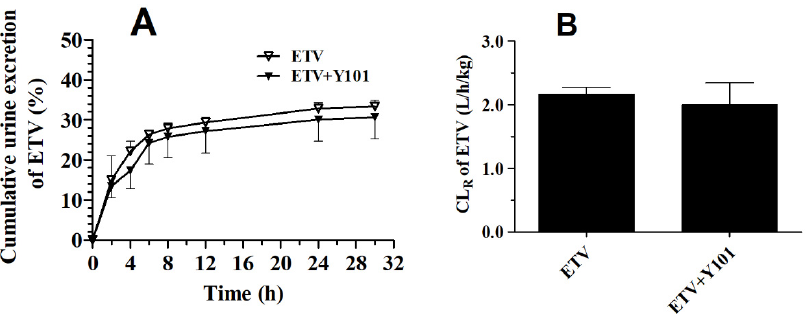
Figure 5. Cumulative urine-excretion curves of ETV ( A ) and the renal clearance of ETV ( B ) after intravenous administration of Y101 (25 mg/kg) and Y101 + ETV (0.06 mg/kg). Data are expressed as mean ± SD (* p < 0.05 vs. ETV group; n = 6).